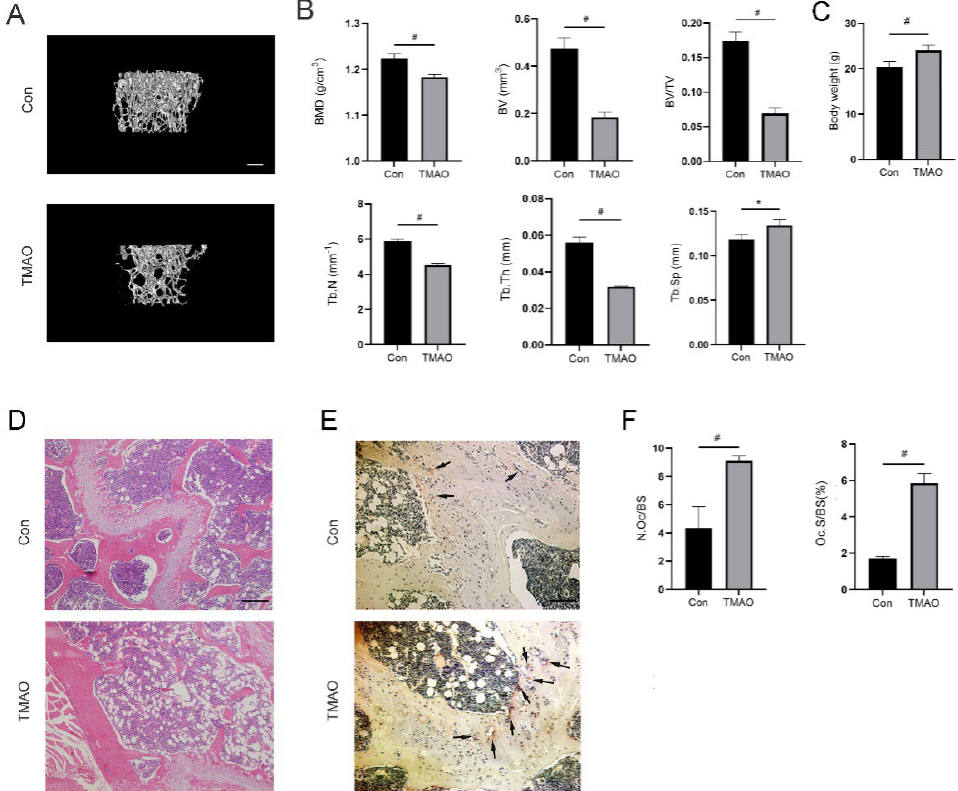
Figure 7. TMAO induced bone loss in mice. ( A ) Representative micro-CT reconstruction images of femur from mice of control and TMAO groups. Scale bar = 400 µ m. ( B ) Bone parameters of BMD, BV, BV/TV, Tb.N, and Tb.Th in the TMAO group were significantly lower than in the control group, and Tb.Sp in the TMAO group was significantly higher than in the control group ( n = 4 per group). ( C ) Body weight of mice in the TMAO group was significantly higher than in the control group ( n = 6 per group). ( D ) Representative images of HE staining of femur from mice of control and TMAO groups. Scale bar = 5 µ m. ( E ) Representative images of TRAP staining of femur from mice of control and TMAO groups. TRAP-positive osteoclasts are marked by arrows. Scale bar = 5 µ m. ( F ) TMAO significantly increased osteoclast number/bone surface area (N.Oc/BS) and osteoclast area/bone surface area (Oc.S/BS) observed by TRAP staining ( n = 3 per group). * p < 0.05, # p < 0.01.